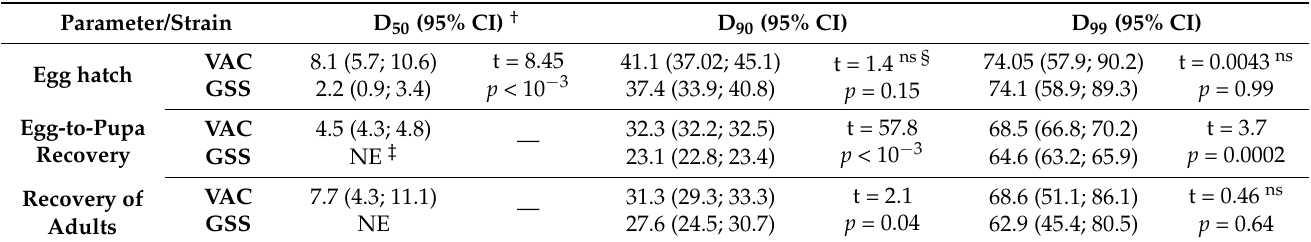
Table 2. Radiation doses (Gy) and their 95% confidence intervals (CIs) estimated from the 4-parameter Weibull model for selected sterility levels of Anastrepha fraterculus males from a bisexual strain (VAC) and a genetic sexing strain (GSS) irradiated under hypoxia.